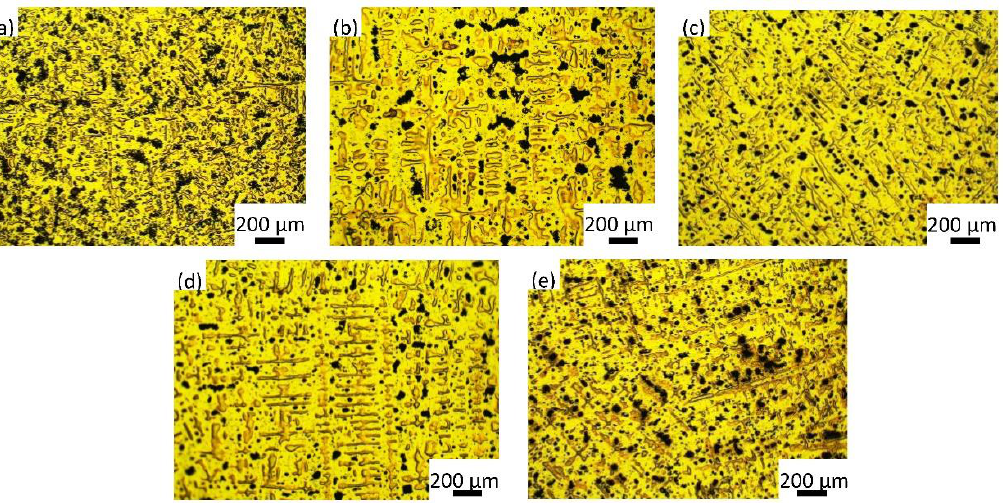
Figure 4. Optical microstructure of ( a ) ZCuSn10Pb10, ( b ) ZCuSn10Pb10 + 0.05% Y, ( c ) ZCuSn10Pb10 + 0.1% Y, ( d ) ZCuSn10Pb10 + 0.15% Y and ( e ) ZCuSn10Pb10 + 0.2% Y.